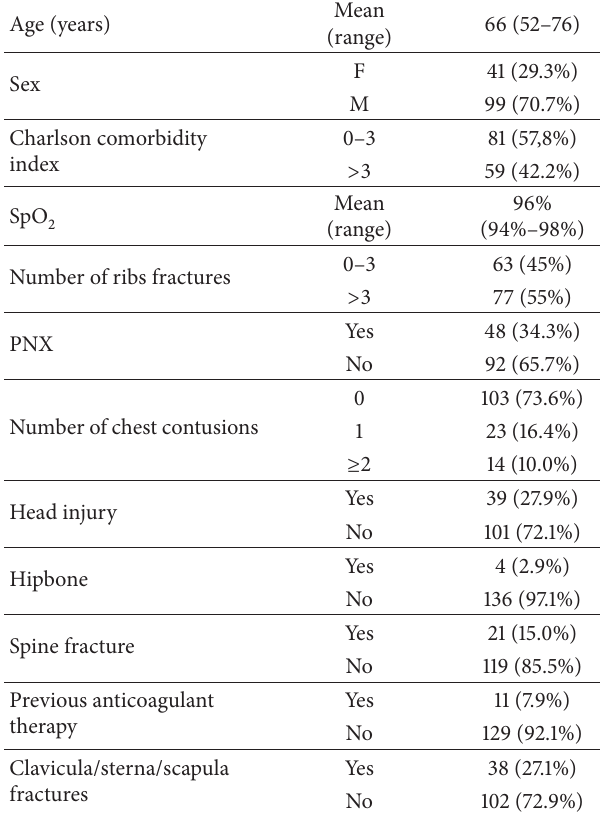
Table 1: Characteristics of patients on